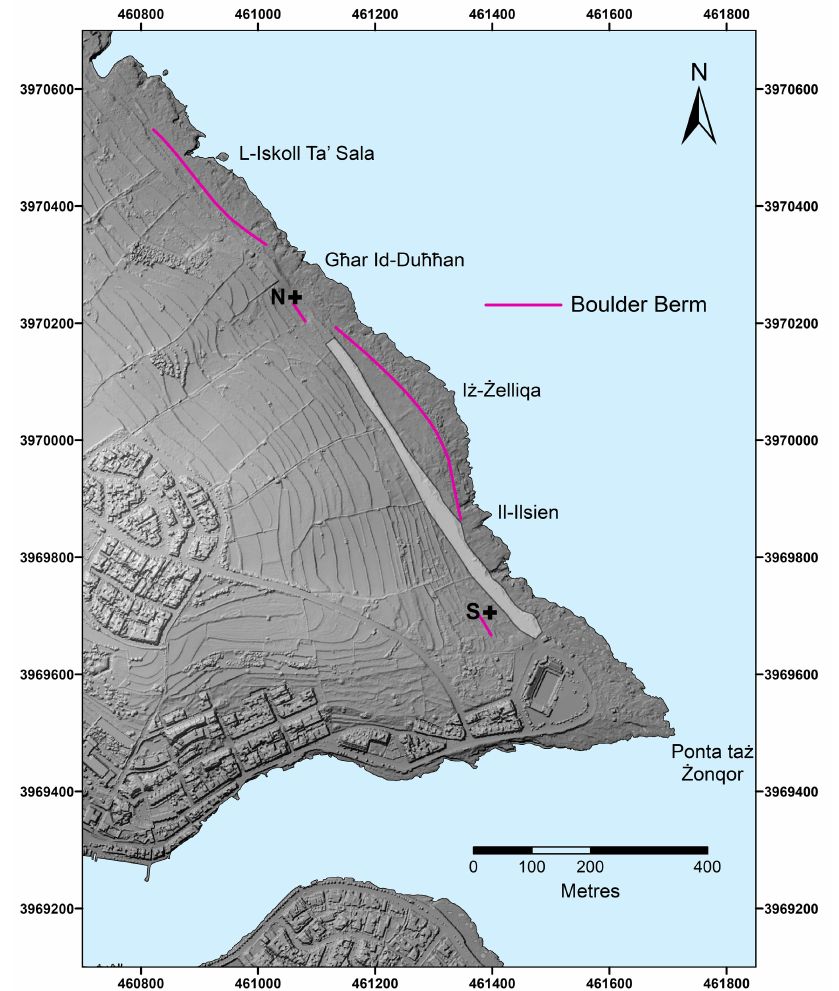
Figure 2. Map of the ˙ Zonqor study site depicting local topographic features: the generalised line of the boulder berm; the locations of the north and south boulder fields (N + and S + ), and; the outline of made ground (grey polygon) that buries surficial geomorphic evidence. Hill shading is based on Light Detection And Ranging (LiDAR) at 1 m pixel